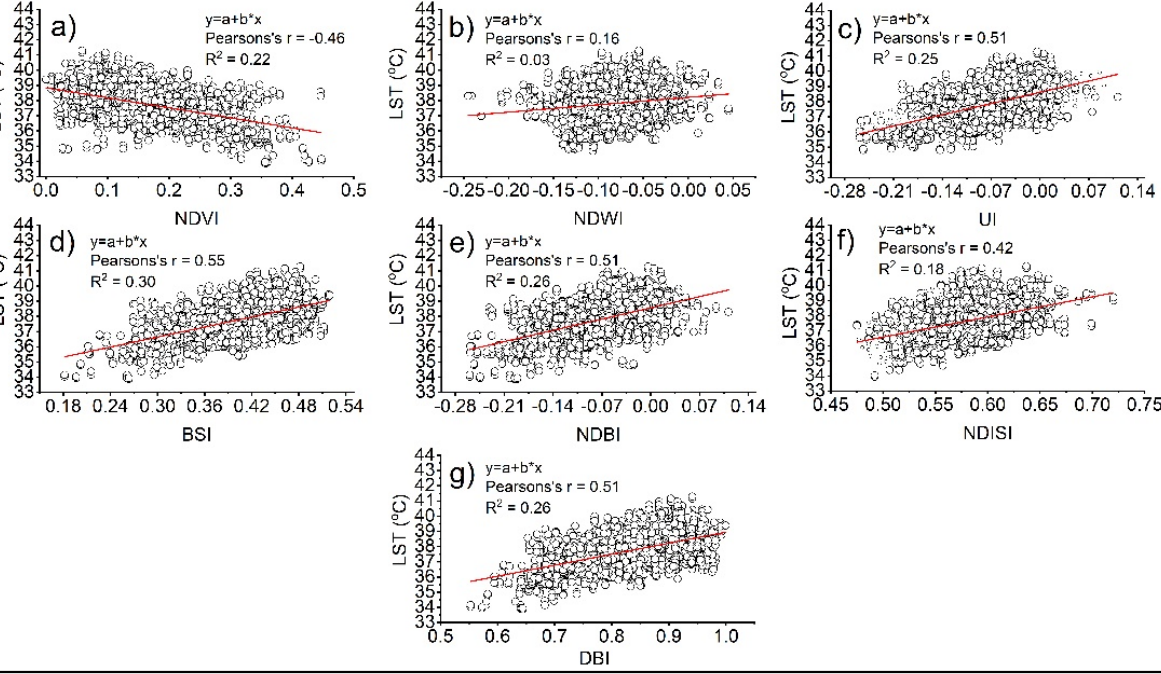
Figure 5. Relationship between LST and LULC indices in transect II, ( a ) NDVI, ( b ) NDWI, ( c ) UI, ( d ) BSI, ( e ) NDBI, ( f ) NDISI, ( g )